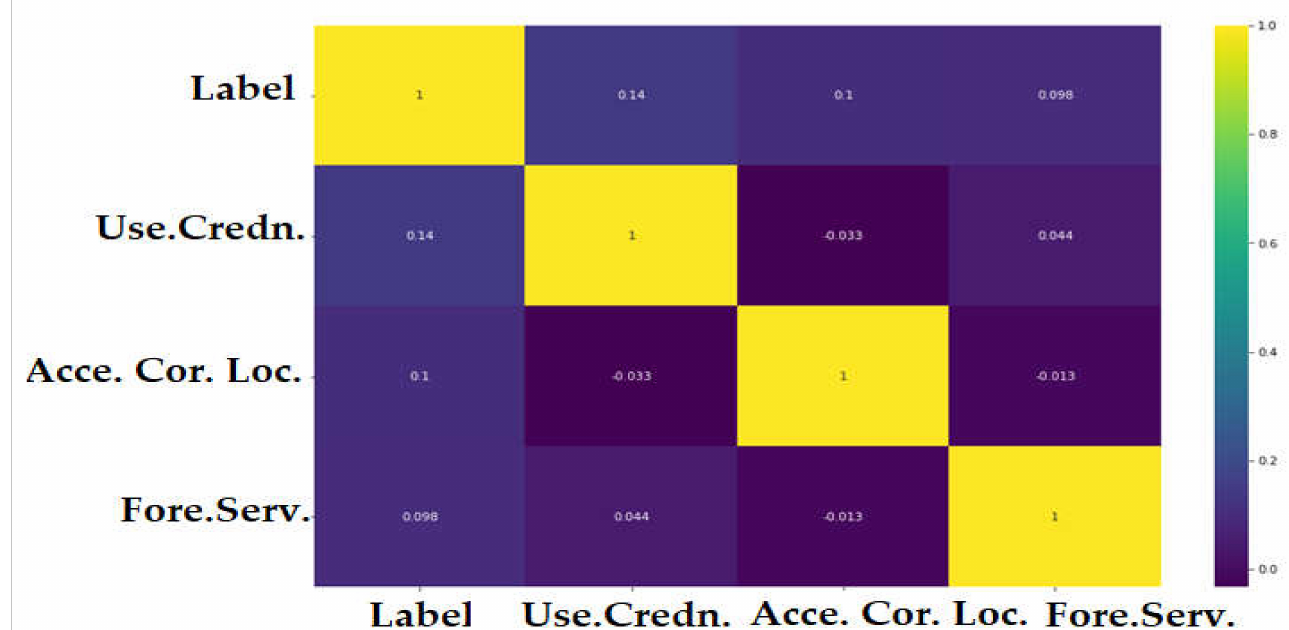
Figure 19. The correlation coefficient results using the CICAndMal2017 dataset.